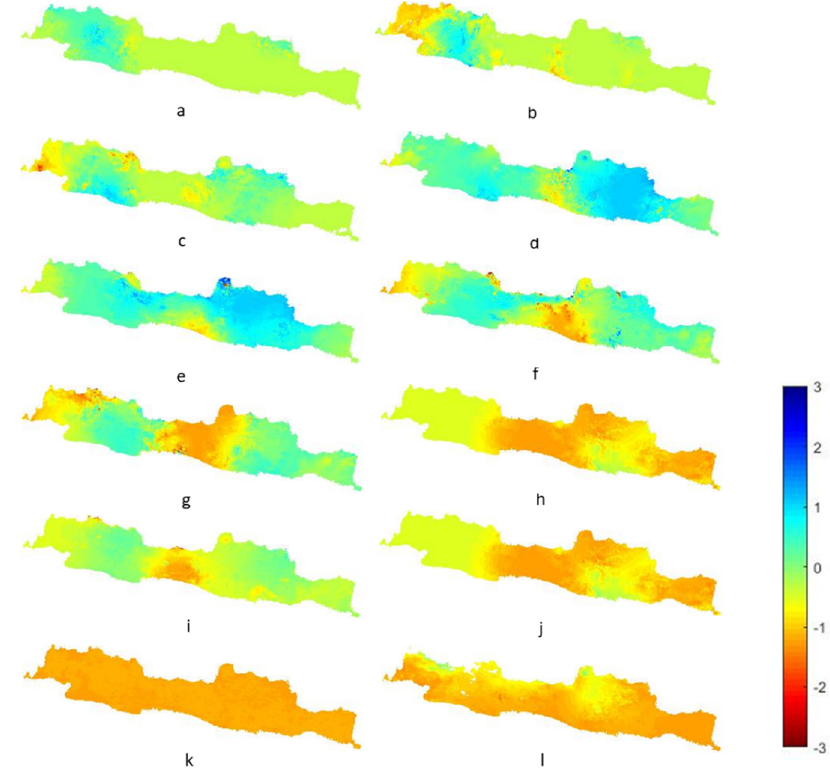
Figure 7. Monthly fine-resolution SPI 6 maps from January to December ( a – l ), 2019.